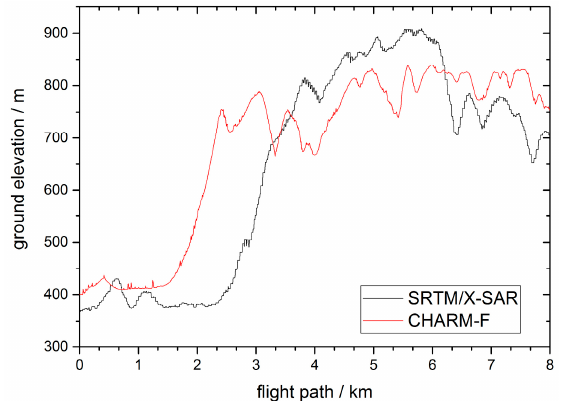
Figure 5. Example of large pointing deviations (500 m laterally and longitudinally shifted assumed ground spot trace): The application of an extended check interval (here: 8 km, 2000 lidar measurement points) results in usable correlation coefficients for the application of the method under these conditions.